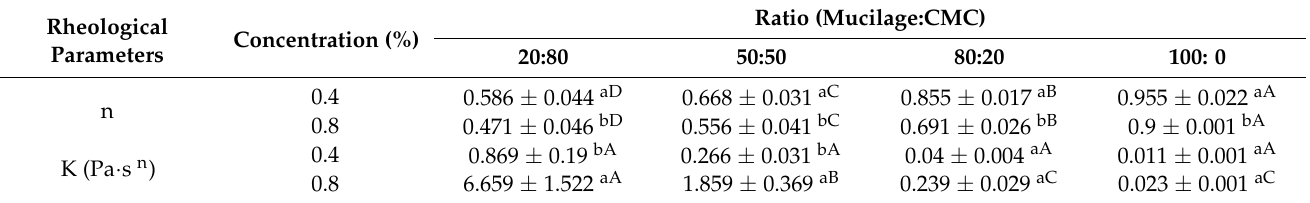
Table 3. Rheological parameters estimated from Oswald–de Waele model of vanilla-flavored soft serve ice cream mixture.